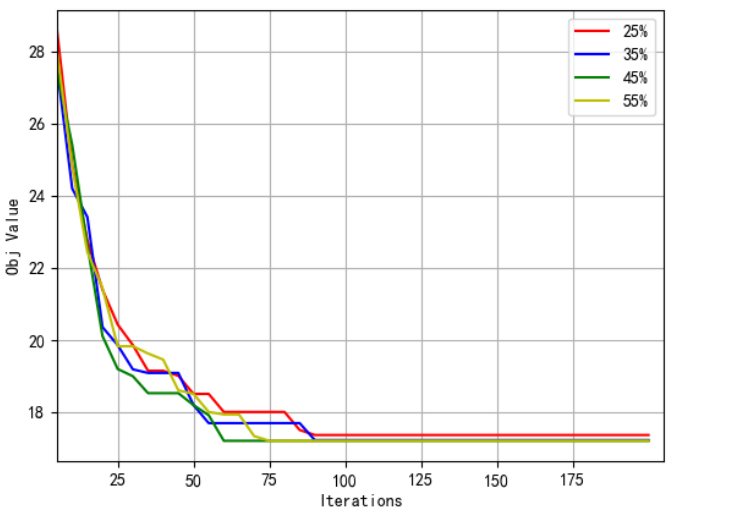
Figure 11. The convergence of different drone surveillance targets in the initial